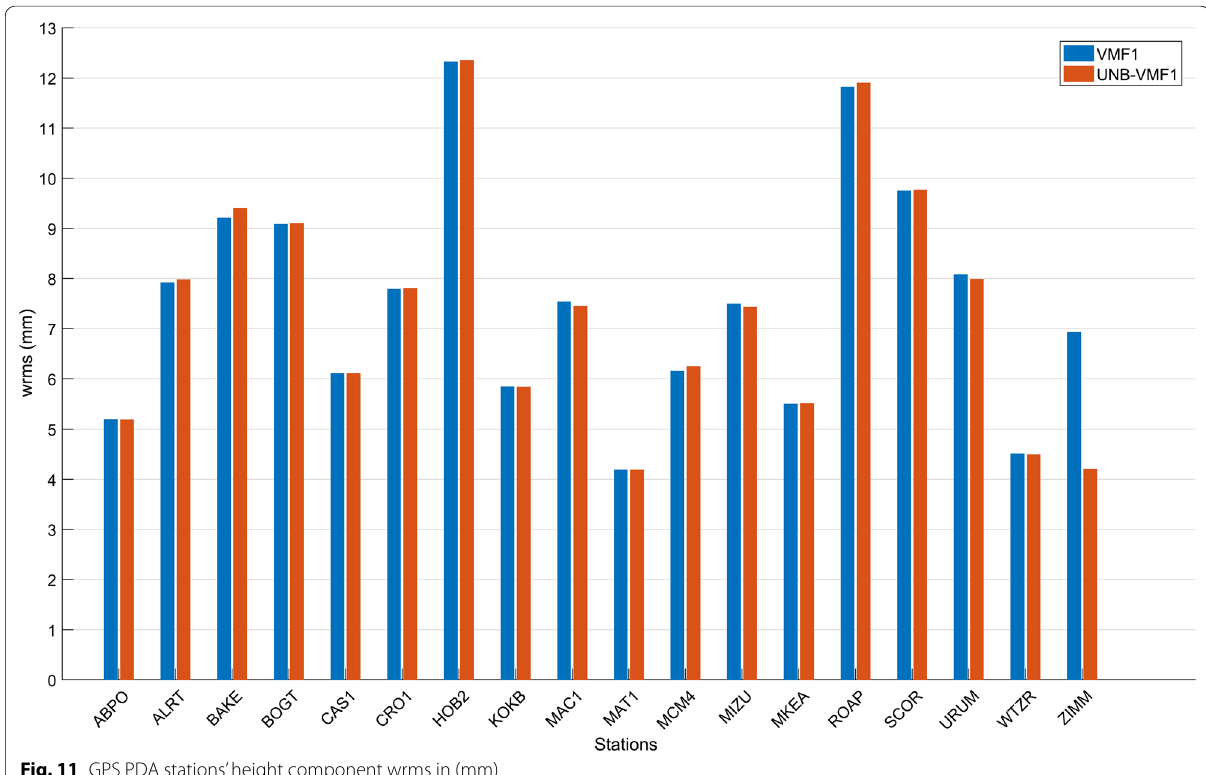
Fig. 11 GPS PDA stations’ height component wrms in (mm)